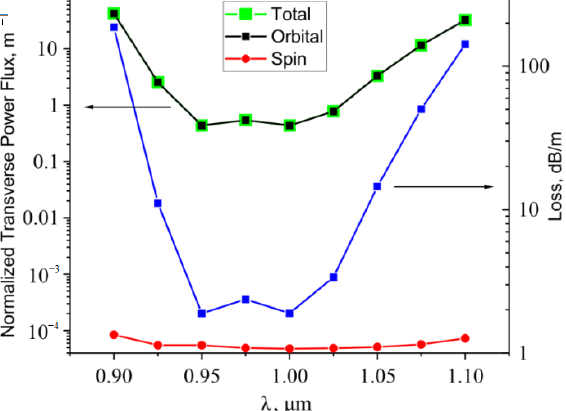
Figure 8. Waveguide loss dependence of the spin and orbital parts of the transverse component of the Poynting vector of the fundamental core mode on a wavelength for ASBGF described in the text (circular polarization) in the spectral region near the loss minimum.